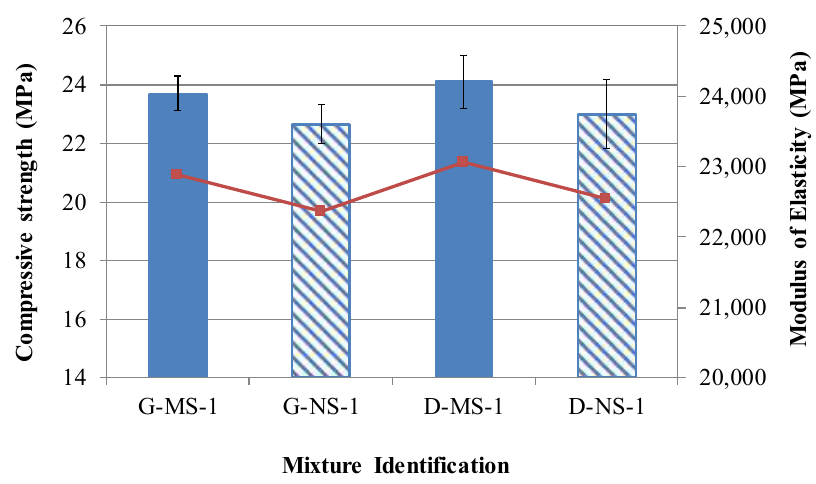
Figure 6. The results of the compressive strength and the modulus of the elasticity.